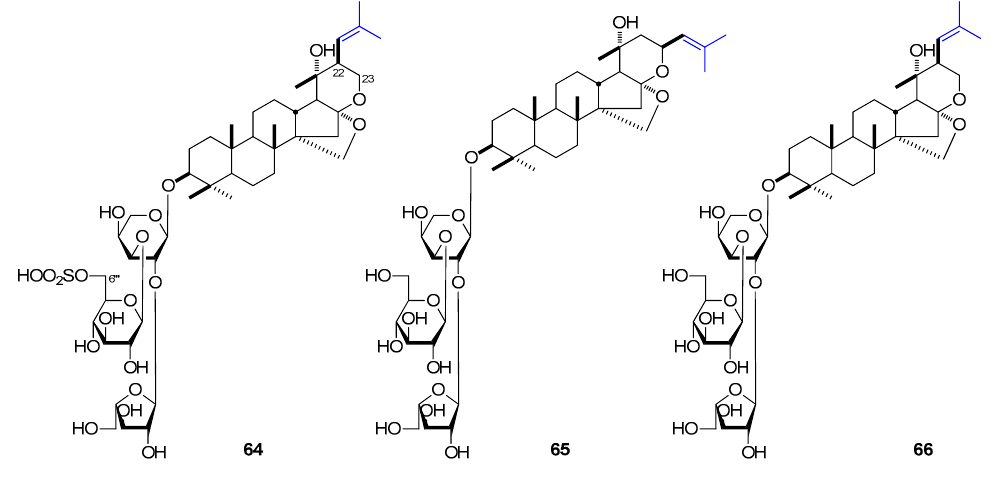
Figure 6. The structure of compounds 64 – 66 .